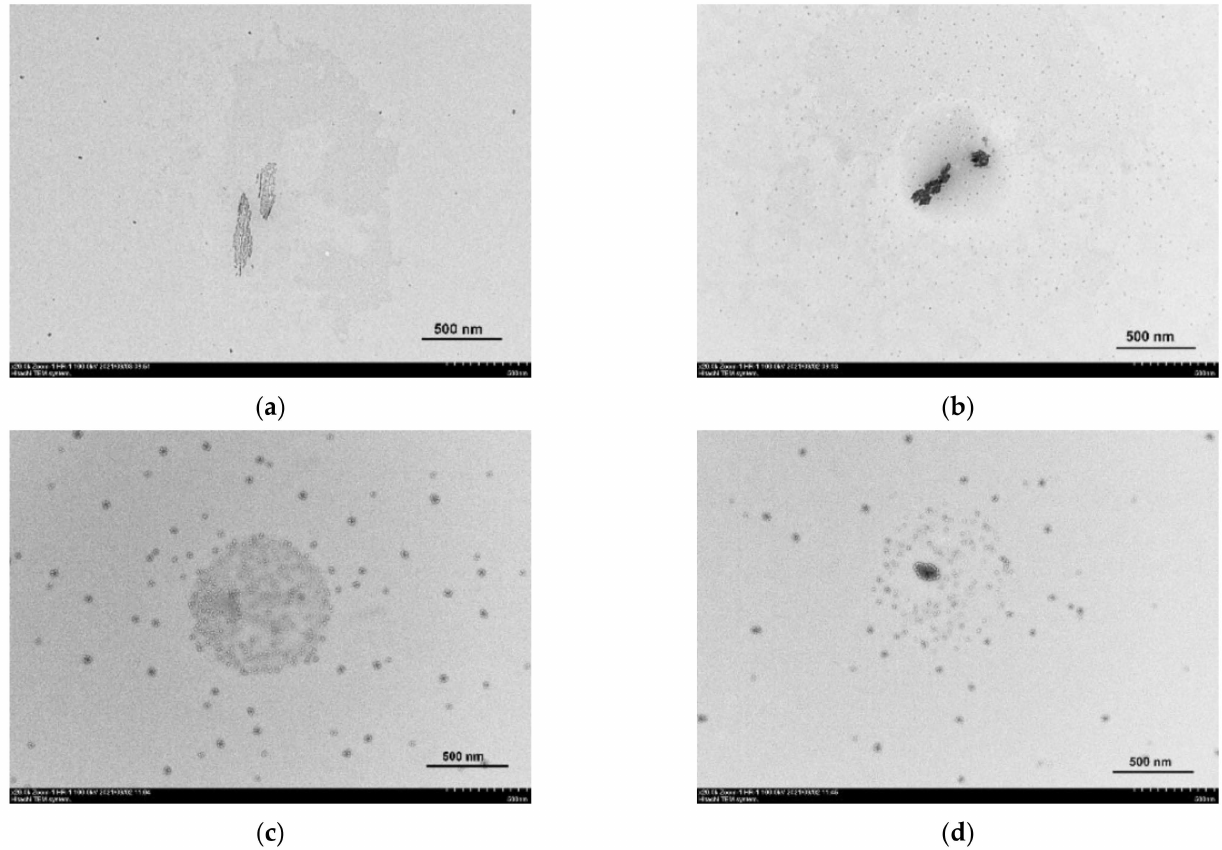
Figure 6. TEM images of TSPP in the absence ( a ) and presence of an equimolar amount ( b ), a two-fold ( c ), and three-fold ( d ) excess of